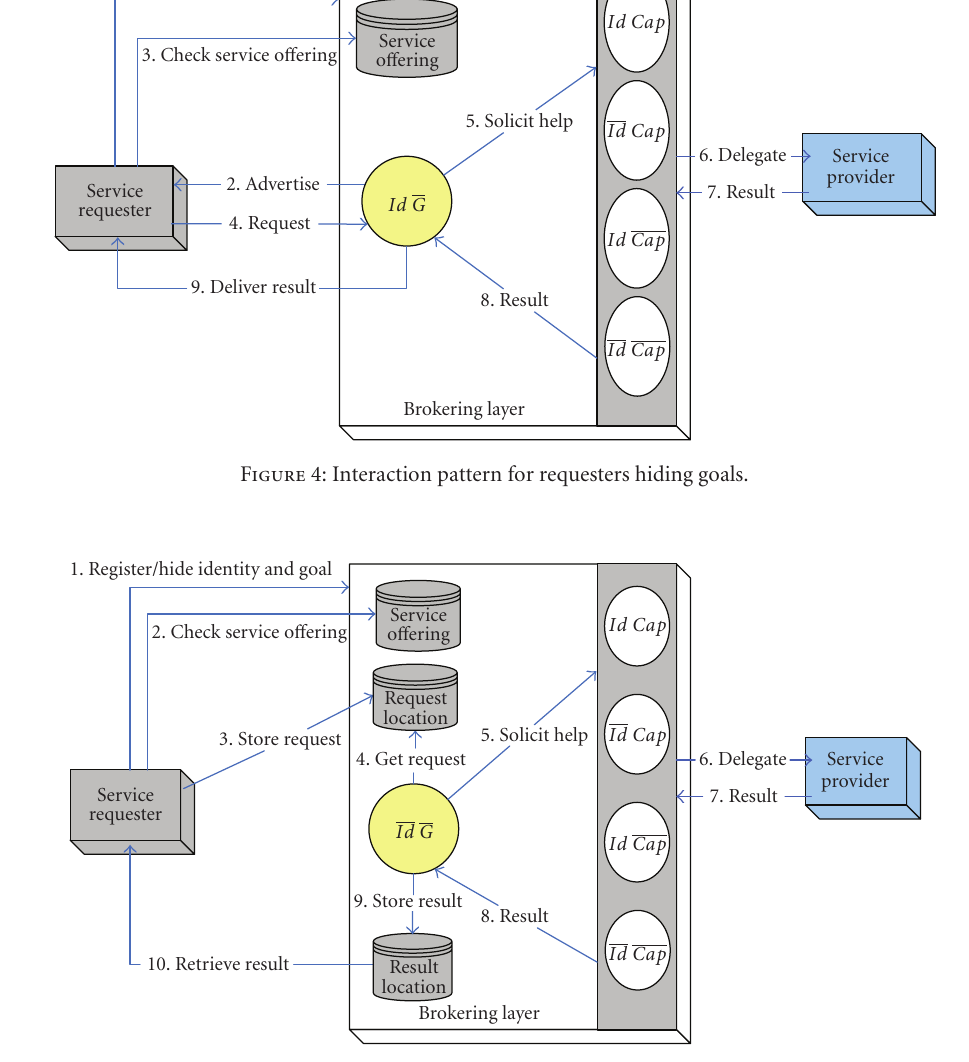
Figure 5: Interaction pattern for requesters hiding privacy